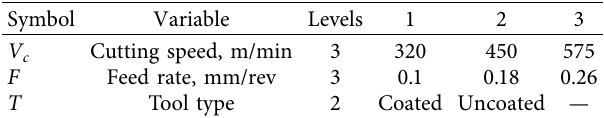
Figure 2: Surface roughness measurement setup. Table 3: Input variables and levels.